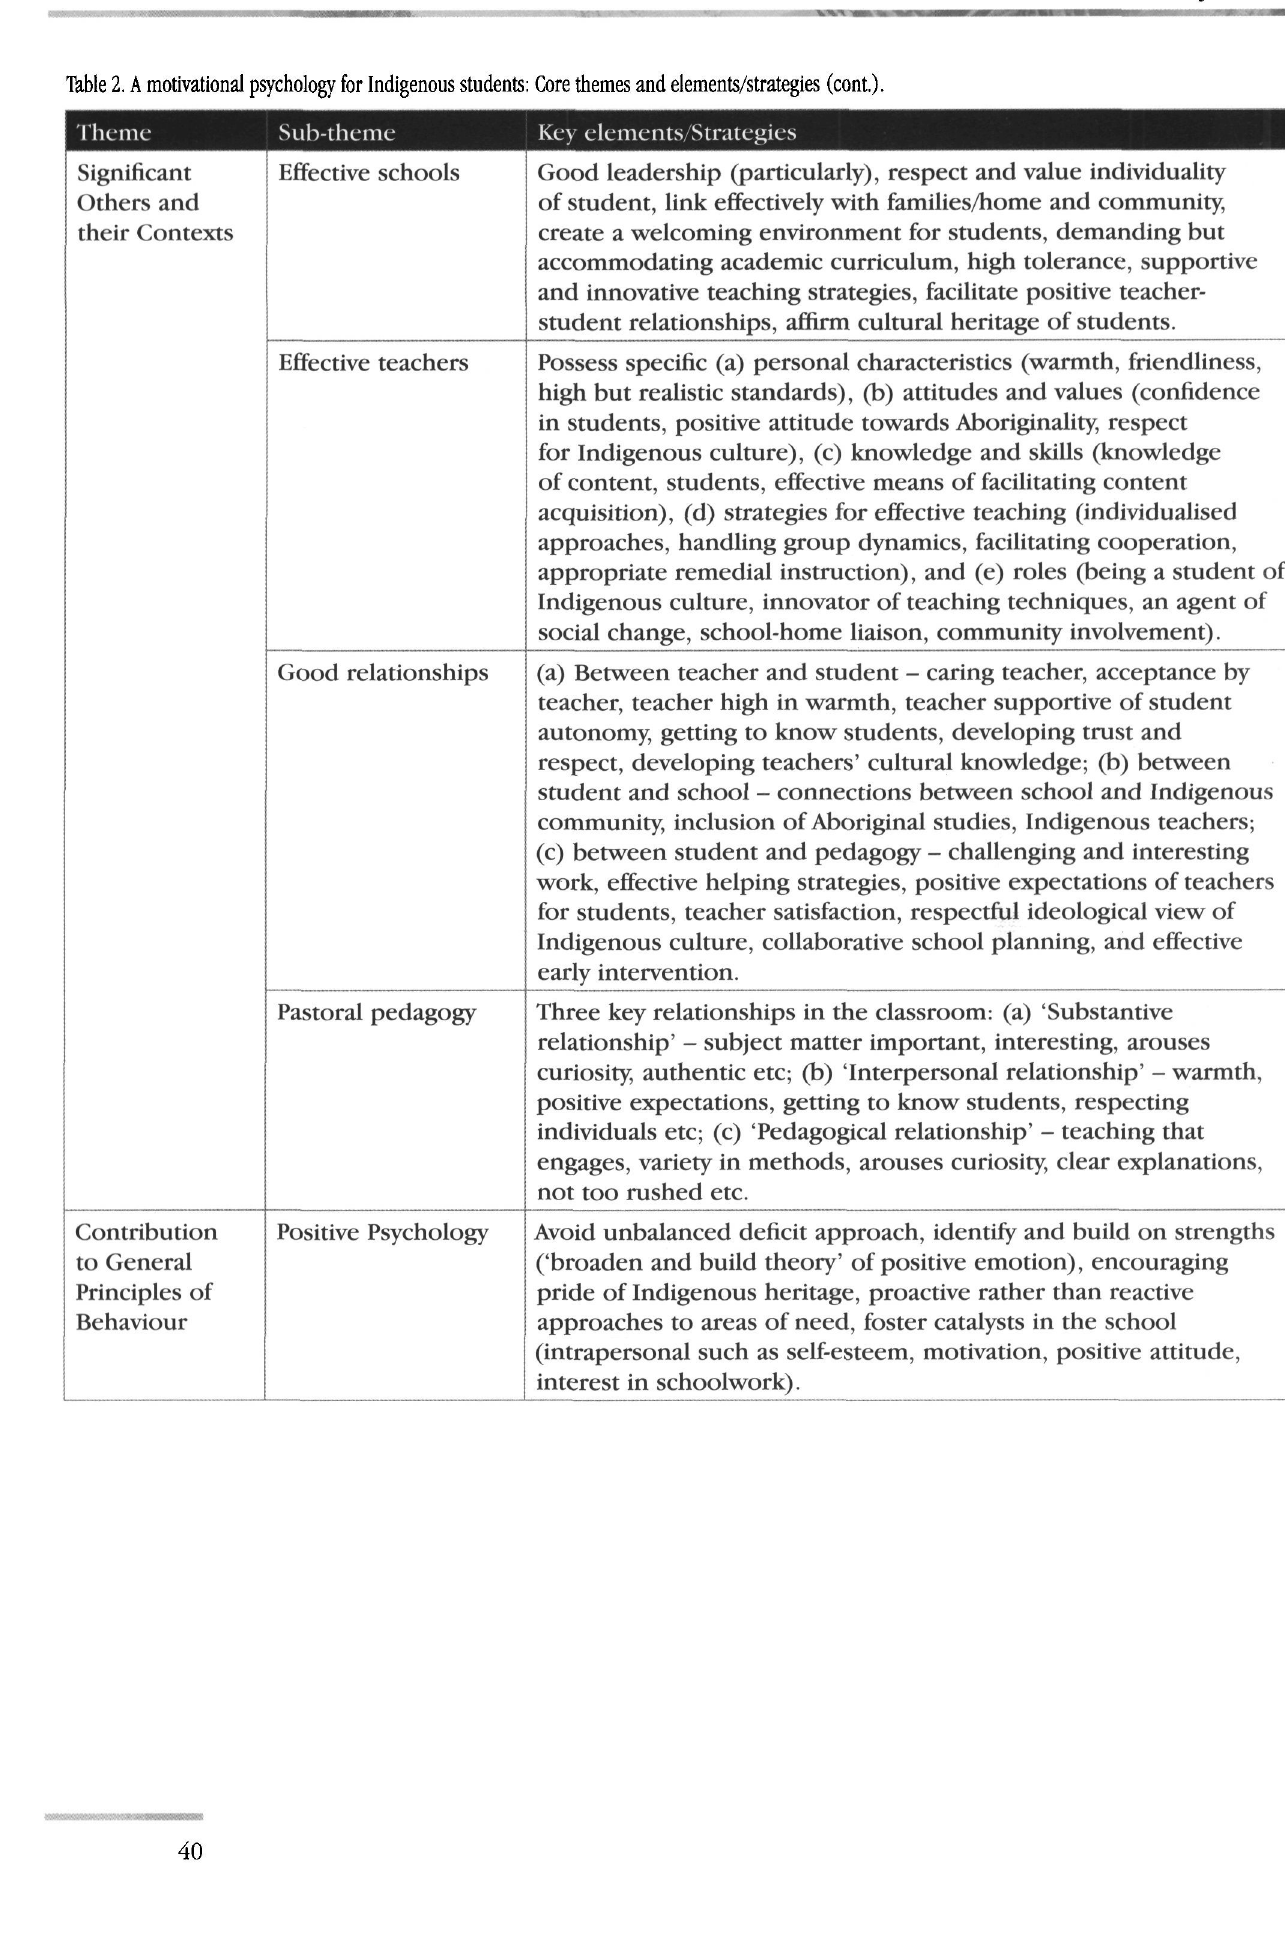
Table 2. A motivational psychology for Indigenous students: Core themes and elements/strategies